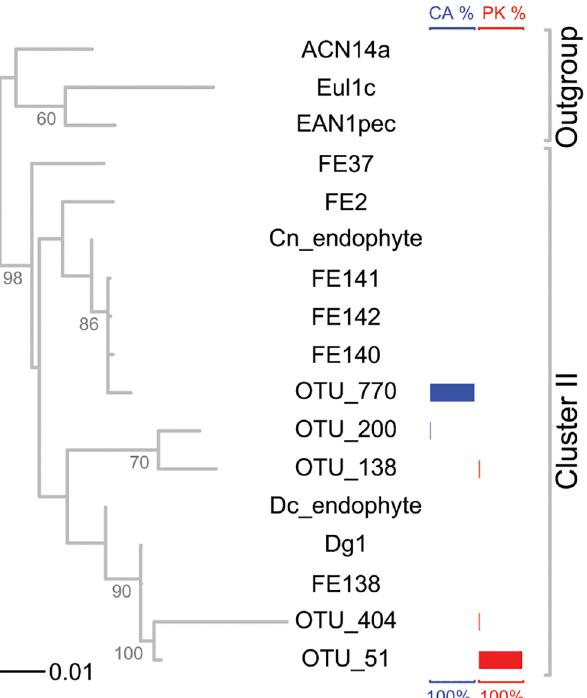
III Frankia strains are used as outgroups. Branches with bootstrap values of 50 or higher are indicated in the figure. * : Cn endophyte sequence only contains v2 region. Relative abundances of each Frankia OTU are shown in colored bars to the right; blue indicates each OTU's percent of Frankia reads in nodules of plants inoculated with material from California (CA), red indicates percent in nodules of plants inoculated with material from Pakistan